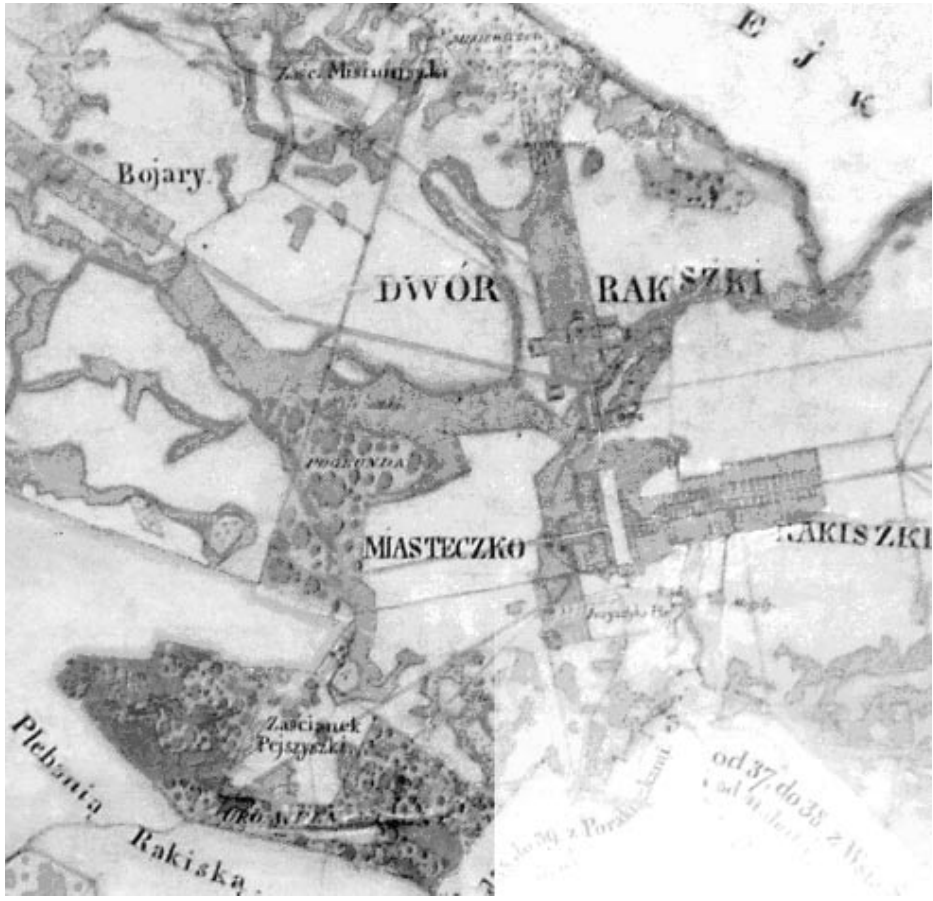
Fig 2. Part of the map of Rokiškis county, scale 1:27,000 (decreased by 10 times) and a fragment of the map of the centre of